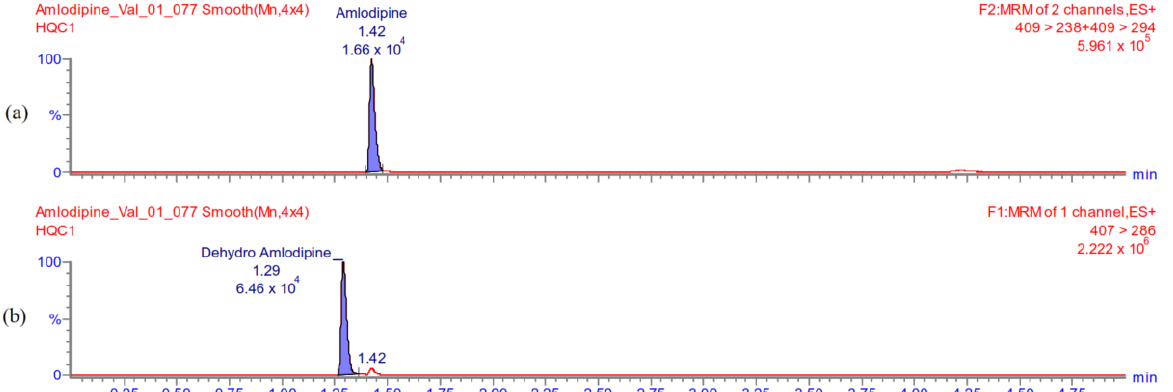
Figure A4. MRM chromatograms of human blood plasma sample spiked with AML and DAML. ( a ) AML (1.42 min) and ( b ) DAML (1.29 min) both at 40 ng/mL.